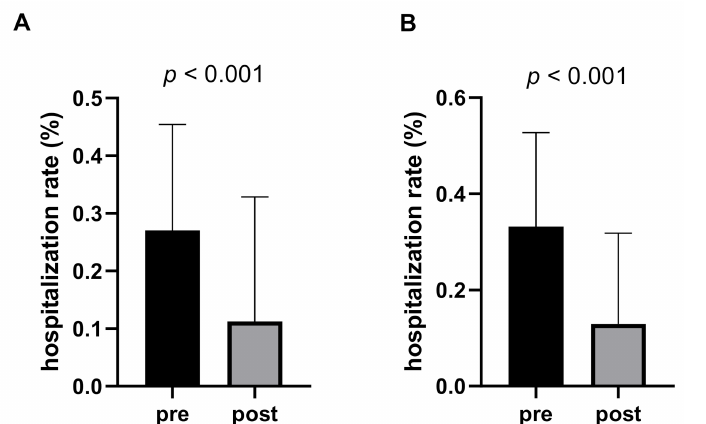
Figure 3. Hospitalization rate (% days) within 90 days pre-PleurX insertion (“pre“) and within 30 days post discharge from the hospital (“post“). ( A ): all patients ( n = 51); ( B ): patients with drainage in situ after 30 days ( n =